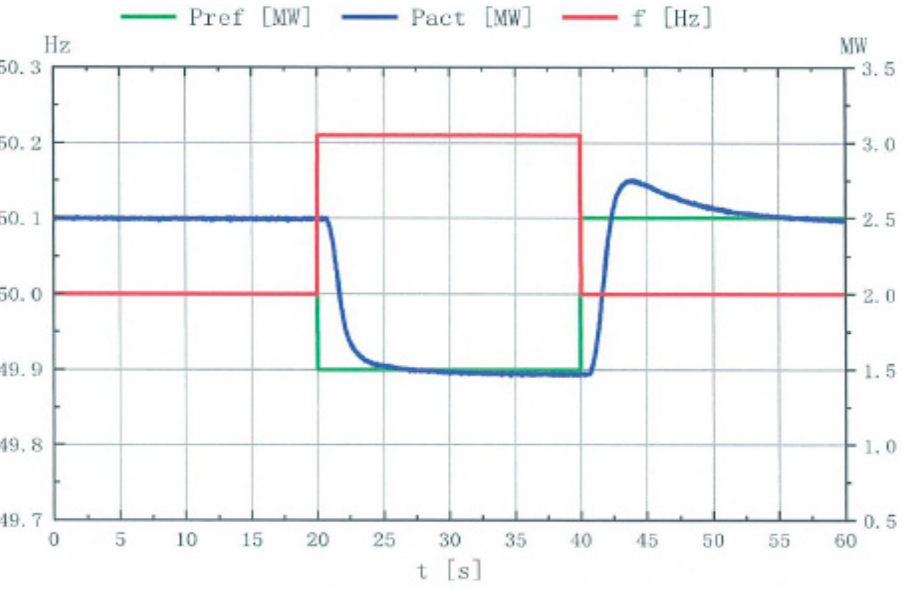
Figure 7. Frequency upward step with successful FFR (proportional) response waveform.